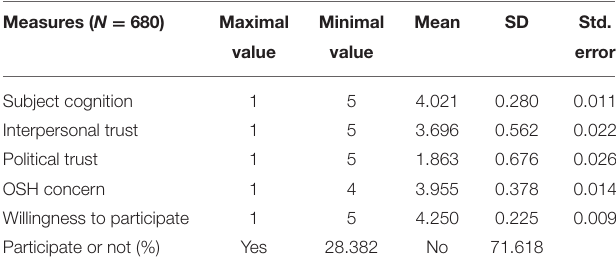
TABLE 3 | Correlation matrix. TABLE 4 | Descriptive statistics of determinants used in the